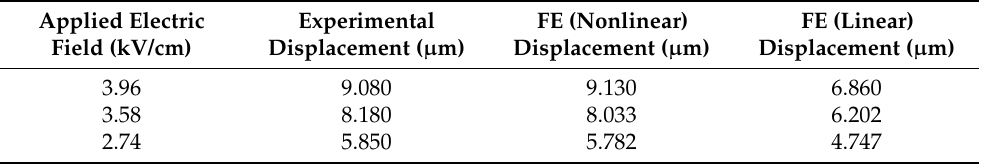
Figure 11. Comparison of linear and nonlinear FE models in terms of generated tip deflection versus applied electric field. Table 3. Displacement and 𝒅 𝟏𝟓 values of thickness shear-mode composite actuator.